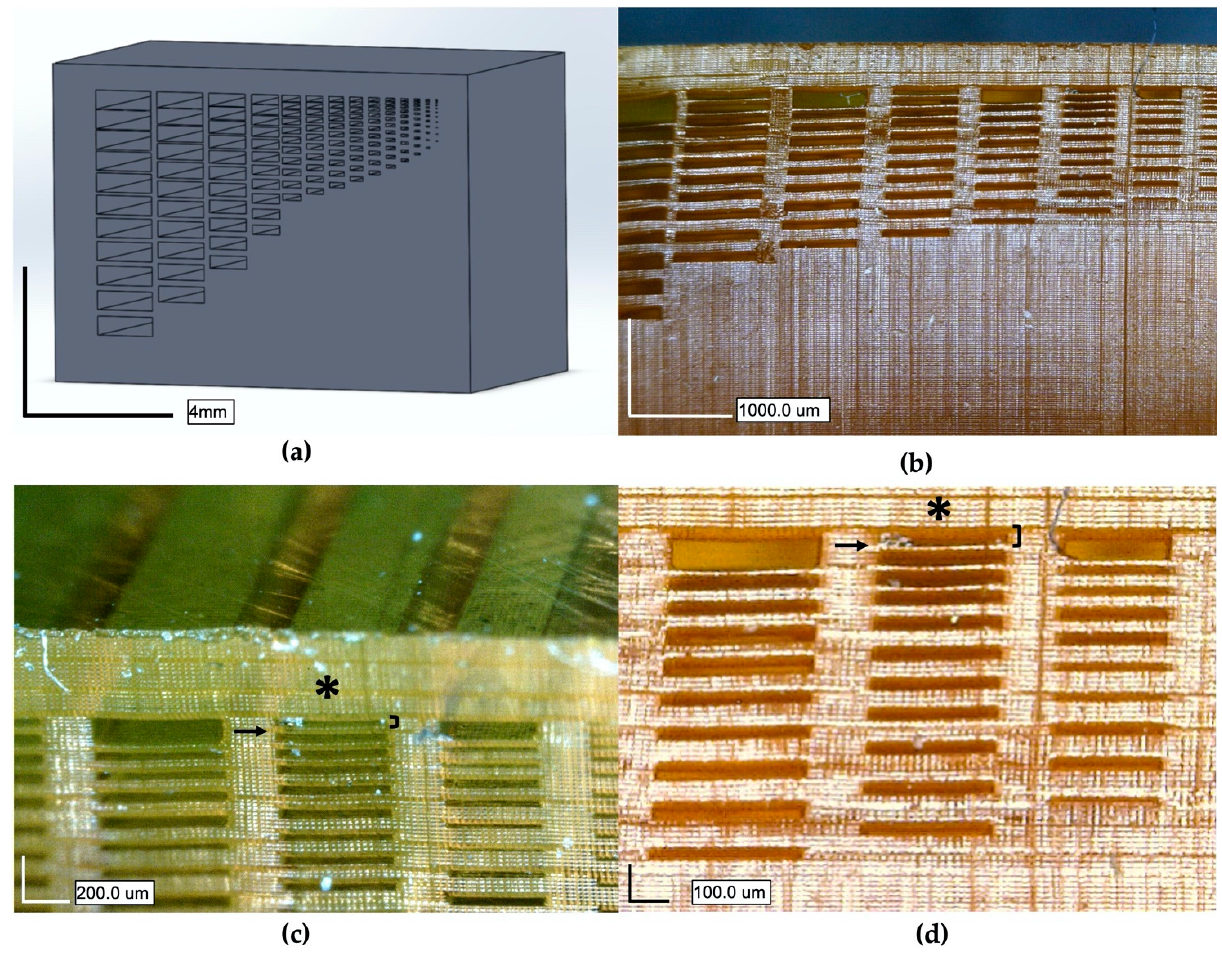
Figure 4. ( a ) A 3D CAD drawing of a test structure with microchannels of varying heights (10–300 µ m) and membrane thicknesses (10–100 µ m) to characterize resolution; ( b ) front view of the 3D-printed structure; ( c ) isometric, front view of the channels showing channels void of uncured resin along the top of the part; ( d ) close-up, front view of channels. Asterisk (*) denotes smallest printed channels successfully cleared of uncured polymer exposing 58.4 ± 1.7 µ m channel heights (denoted by brackets), with membranes as thin as 20.9 ± 0.5 µm (denoted by arrow).